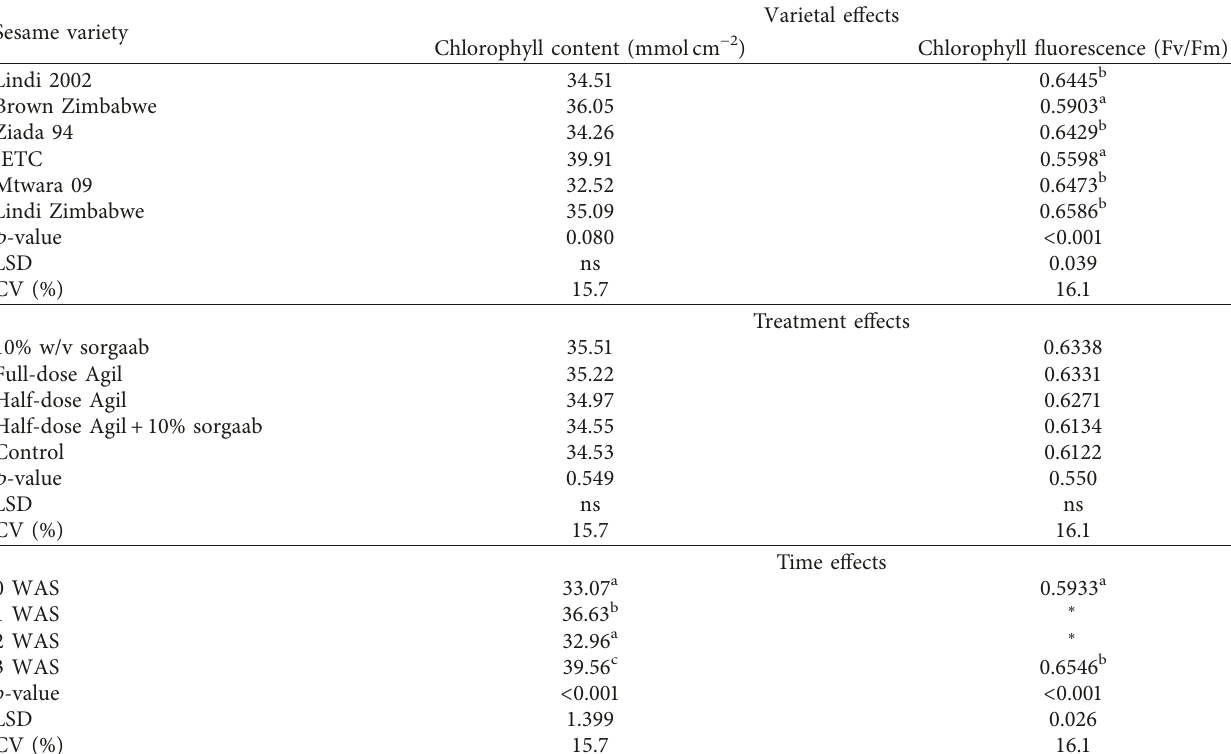
Table 4: Effect of variety, treatments, and time on the chlorophyll content and chlorophyll fluorescence of six sesame varieties.